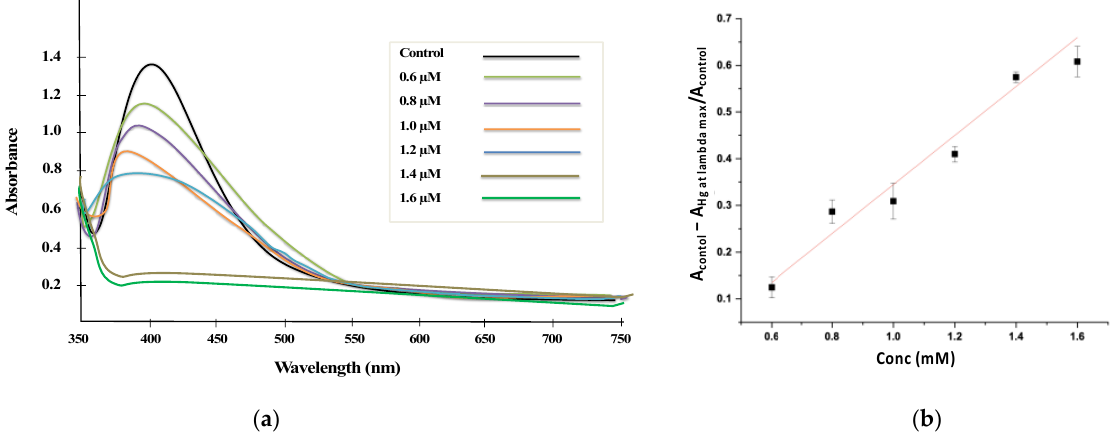
Figure 7. UV – Vis spectra ( a ) and Calibration curve ( b ) for the interaction of various concentrations of Hg +2 ions.